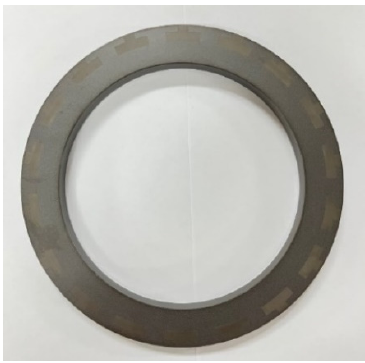
Figure 5. Geometry of T-groove dry gas seal. Table 3. Geometric parameters of the grooved seal.